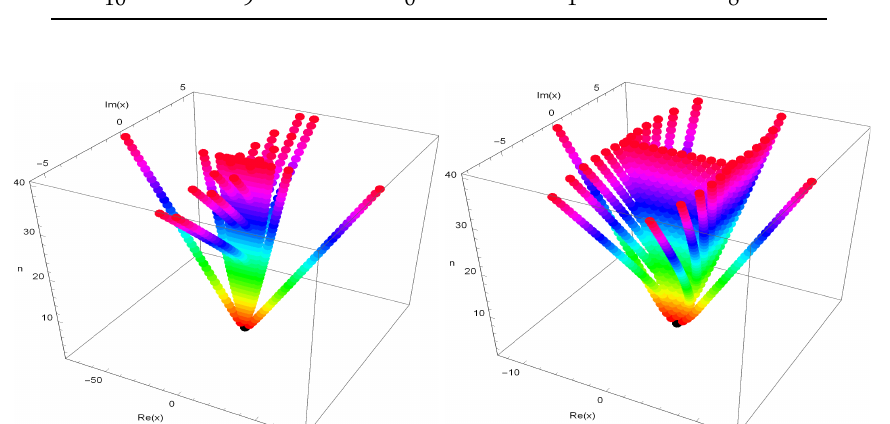
Figure 4. Real zeros of E